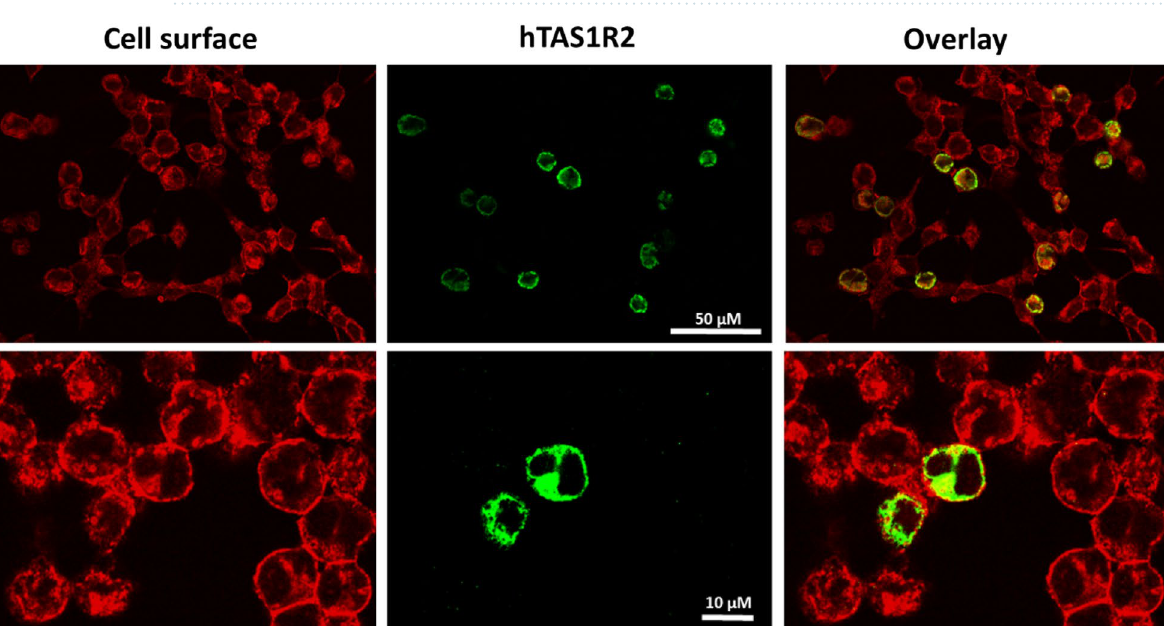
Figure 2. Immunocytochemistry of hTAS1R2-inducible HEK293S cells treated with tetracycline and NaBu. Cells from clone 7 were treated with 1 µg/mL tetracycline and 5 mM NaBu for 48 h. The level of induced hTAS1R2 protein (shown in green) was detected using a primary anti-FLAG M2 antibody and a fluorescently labelled secondary antibody (Alexa Fluor 488). The cell surface (shown in red) was detected by biotin- conjugated concanavalin A and streptavidin-conjugated Alexa Fluor 568. The overlay images indicate the localization of the receptor at the cell surface (shown in yellow). ( A ) The cells were analysed using an epi- fluorescence inverted microscope (Eclipse TiE, Nikon, Champigny sur Marne, France) equipped with an ×20 objective lens and a LucaR EMCCD camera (Andor Technology, Belfast, UK). ( B ) The cells were analysed